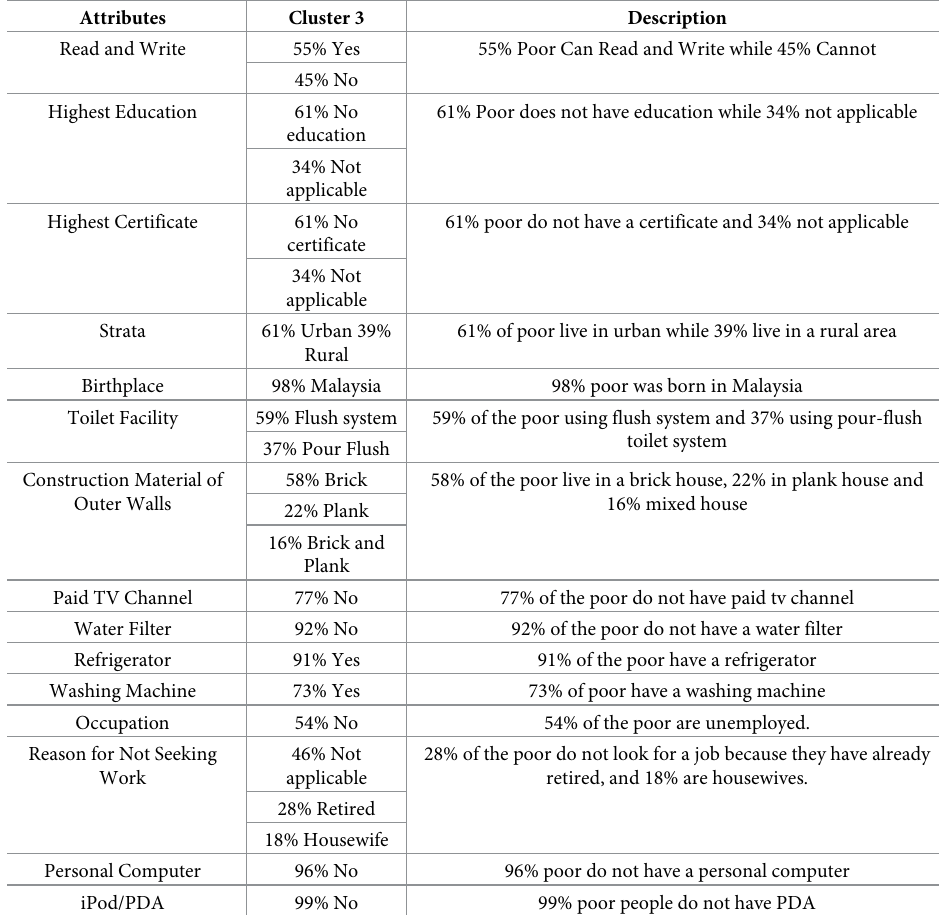
Table 14. Poor characteristic from Cluster